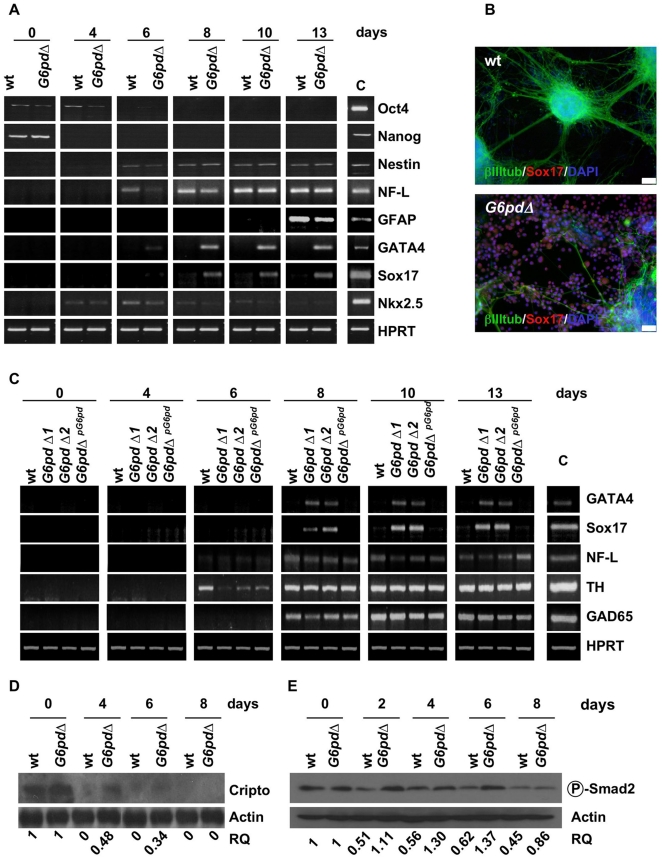
Endodermal induction in G6pdΔ ES cells.(A) Analysis of different markers in wt and G6pdΔ ES cells during neural differentiation. Expression profiles of undifferentiated ES cells (Oct4 and Nanog), neural precursors (Nestin), neurons (NF-L), astrocytes (GFAP), mesendodermal precursors (GATA4), endodermal precursors (Sox17), and cardiac precursors (Nkx2.5) markers were analyzed by RT-PCR. RNA was isolated from cells at different days of differentiation. Lane C, positive control, RNA isolated from 14dpc embryos. Amplified HPRT is shown as a positive control. (B) Double immunostaining Sox17/βIII-tubulin/DAPI of cells at 10 days of differentiation showed areas of immunoreactive cells for Sox17 only in G6pdΔ ES cells. Scale bars, 50 µm. (C) RT-PCR analysis of GATA4, Sox17, NF-L (neural marker), TH (dopaminergic neuron marker) and GAD65 (gabaergic neuron marker) on wt, two different G6pdΔ ES cell lines, and G6pdΔ
pG6pd during differentiation. Lane C, positive control, on RNA isolated from 14dpc embryos. Amplified HPRT is shown as a positive control. (D) Western blot analysis with anti-Cripto and anti-Actin antibodies performed on protein extracts from wt and G6pdΔ ES cells during neural differentiation. Actin was analyzed as loading control. Below each lane the relative quantities (RQ) with respect to related undifferentiated embryonic stem cells are indicated. (E) Western blot analysis with anti-phospho-Smad2 and anti-Actin antibodies performed on protein extracts from wt and G6pdΔ ES cells during neural differentiation. Actin was analyzed as loading control. Below each lane the relative quantities (RQ) with respect to related undifferentiated embryonic stem cells are indicated.